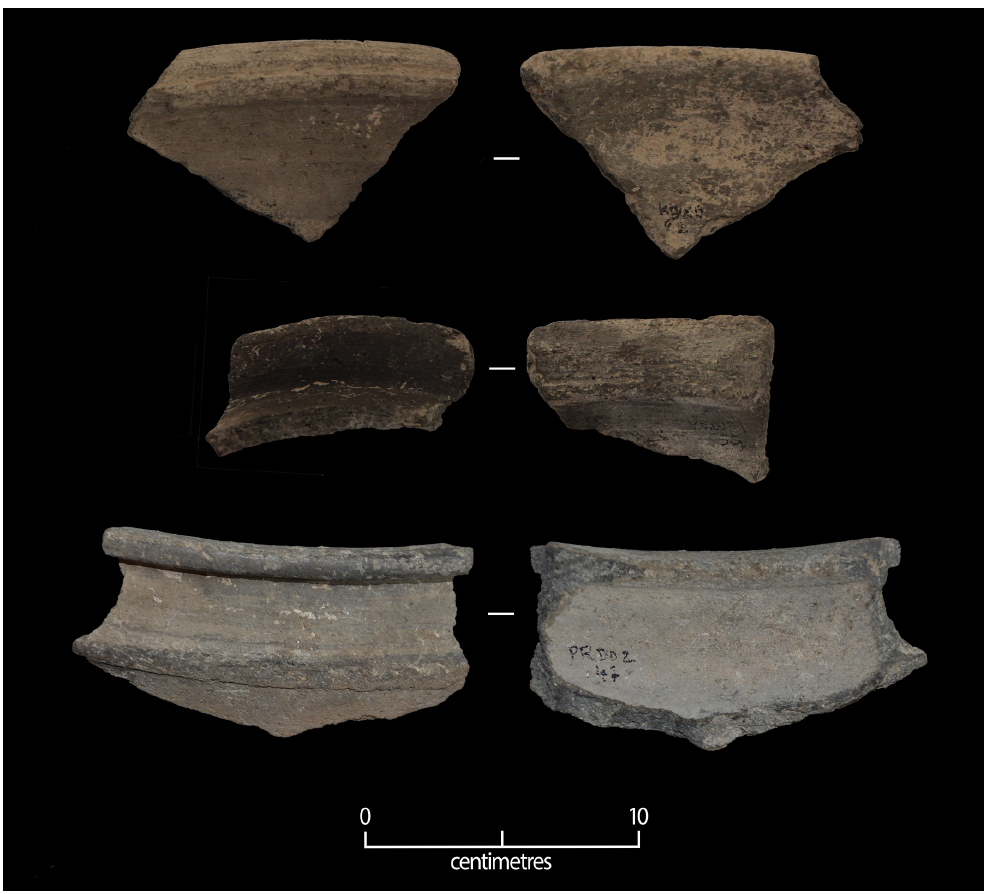
Figure 40: External and internal surfaces of Class 14 variant 5 potsherds.